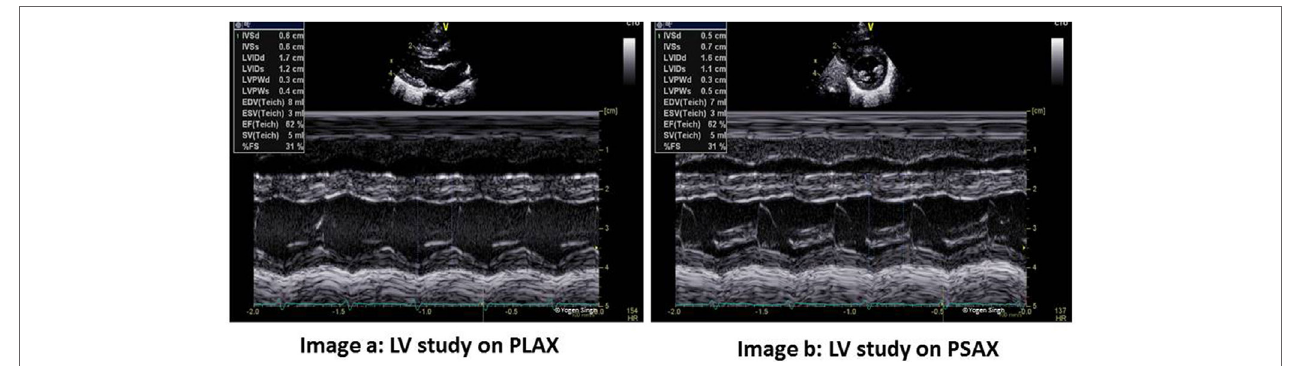
FiGURe 2 | Left ventricle (LV) study in PLAX and PSAX views. FS and EF can be measured reliably on both views - image a shows FS measurement in PLAX and image b shows same measurement in PSAX view. However, EF probably best measured by Simpson’s method. PLAX, parasternal long axis view; PSAX, parasternal short axis view; LV, LV study; FS, fraction shortening; EF, ejection fraction.